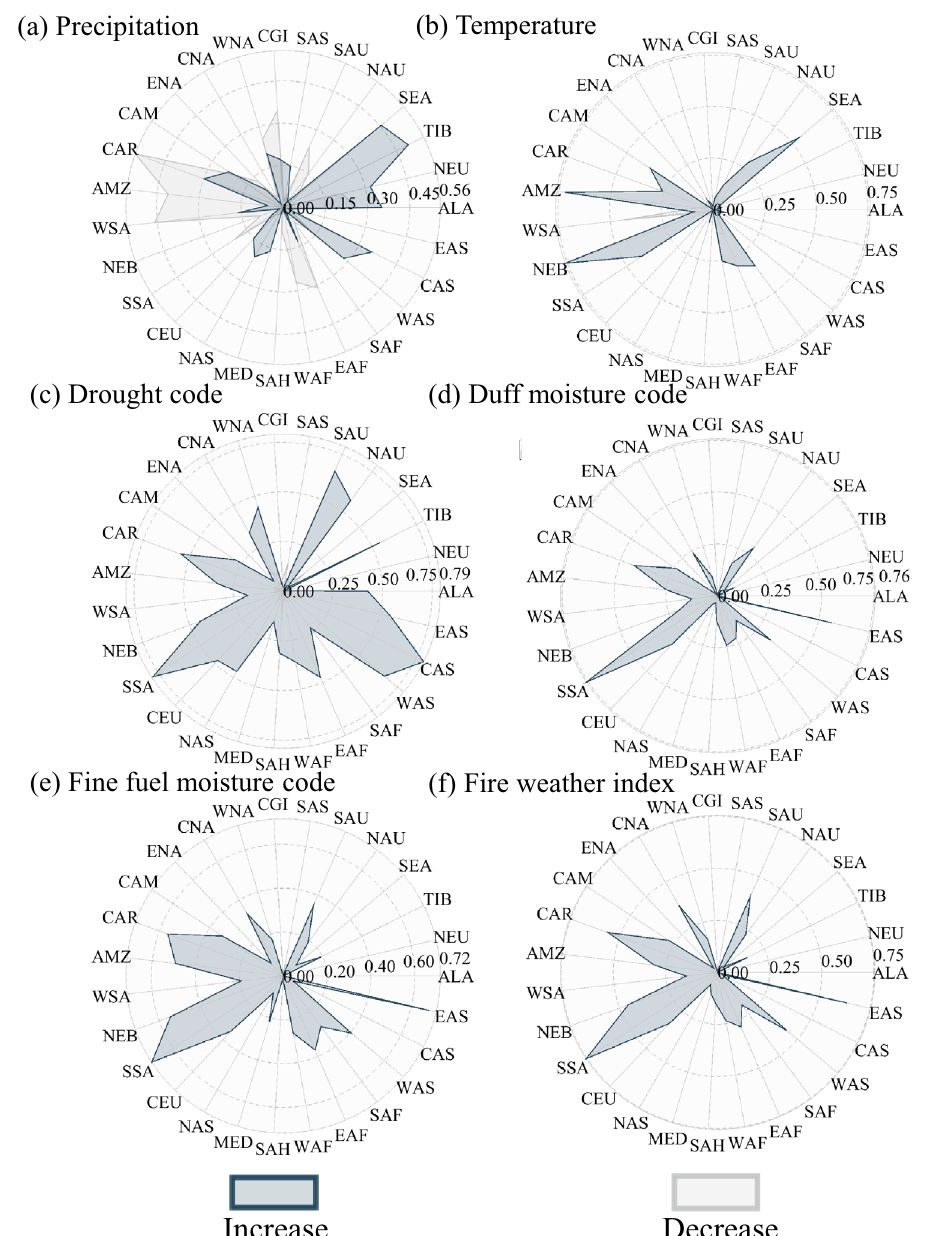
Fig. 7 Percentage of change trend in 27 climate reference regions. The figure shows the proportion of each change trend in the 27 climate reference